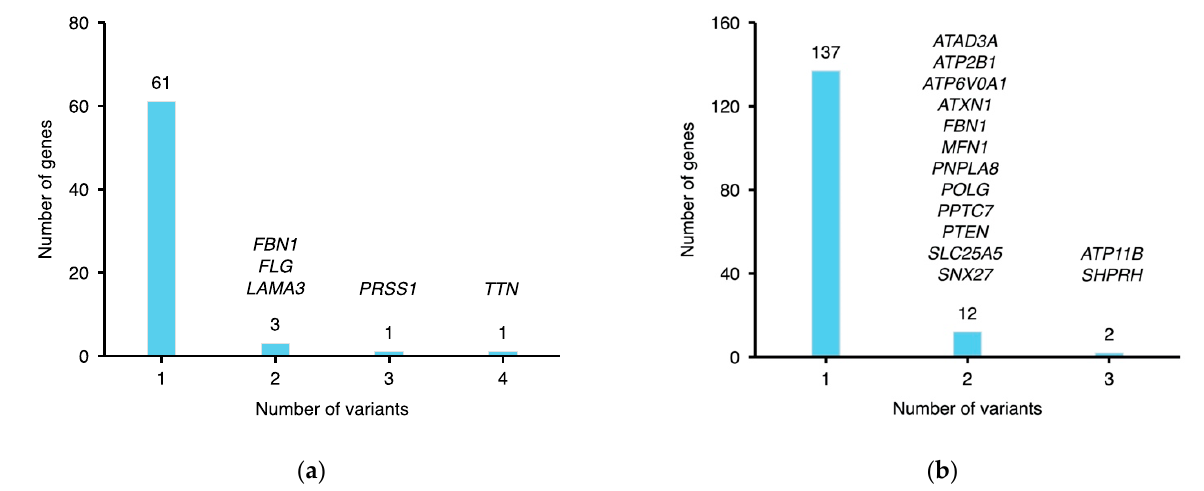
Figure 2. ( a ) MFS pathogenic rare variants predicted by ClinVar; ( b ) MFS pathogenic rare variants predicted by CADD and REVEL scores. Table 4. Rare variants on MFS candidate genes POMT1 , FBN1 , and UNC13D predicted by ClinVar and CADD/REVEL.